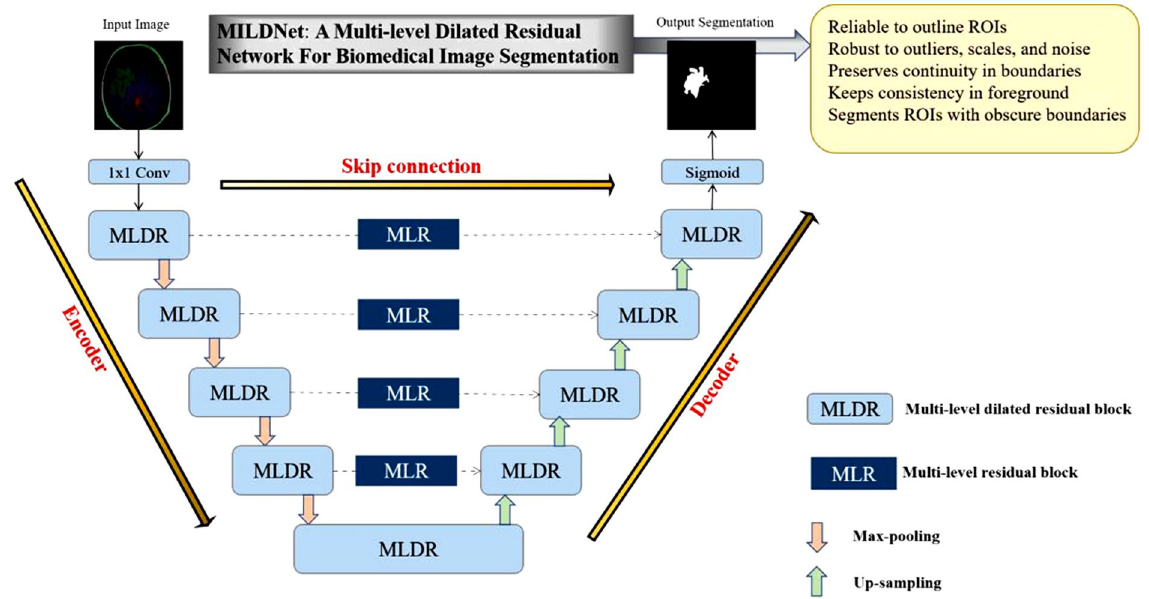
Figure 4. Schematic diagram of the proposed approach for the biomedical image segmentation task. Unlike the convolutional blocks in the classical U-Net, we propose to incorporate the MLDR blocks to overcome some of the classical U-Net limitations, including the difficulty in handling images with variations in tumor sizes and scales. We also propose to use the MLR blocks into the skip connections, as non-linear layers, to further enhance restoring the spatial information, which is usually lost in the classical